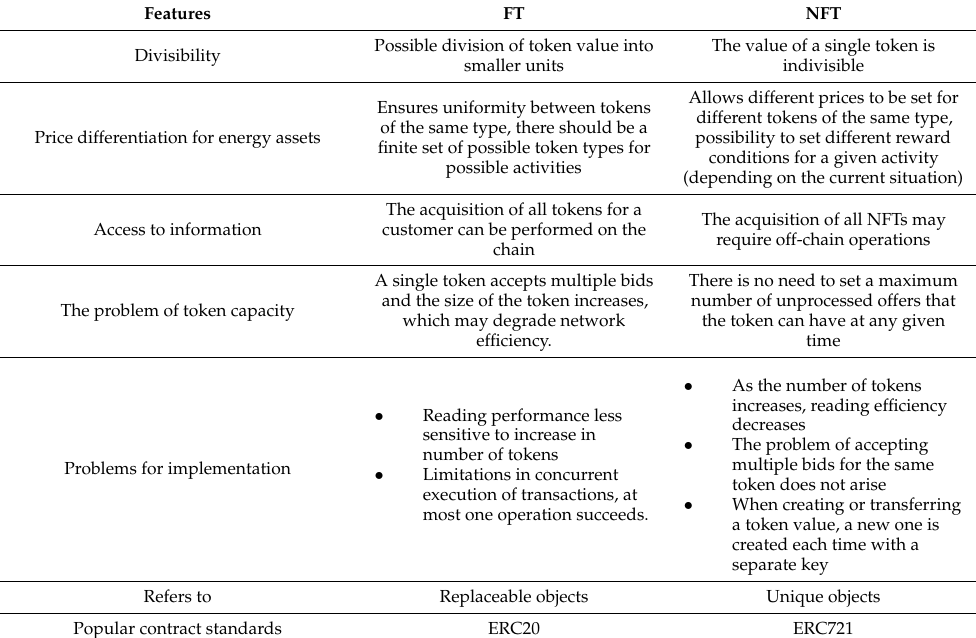
Table 1. Features of Fungible Tokens (FT) and Non-Fungible Tokens. Own elaboration based on information from